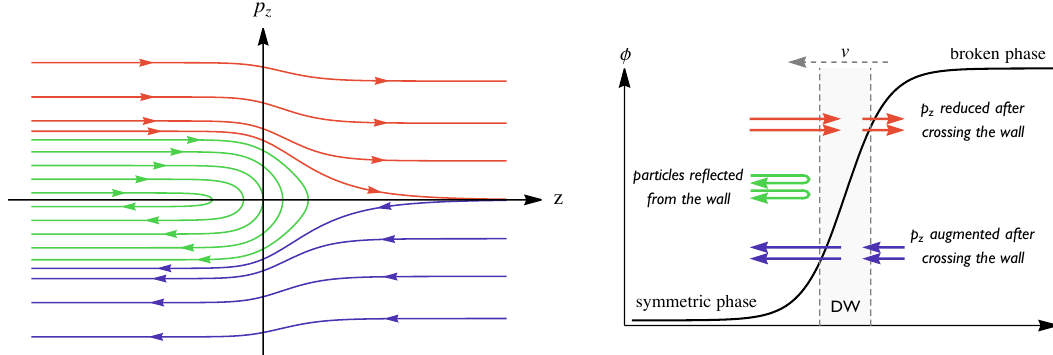
Figure 1 . Left panel: paths with fixed energy and transverse momentum in the z − p z phase space for the choice m ( z ) ∝ 1 + tanh( z/L ) . The red, green and purple colors denote sets of contours with different behavior. The arrows show the flow of a particle within the phase space. Right panel: schematic representation of the behavior of the particles across the